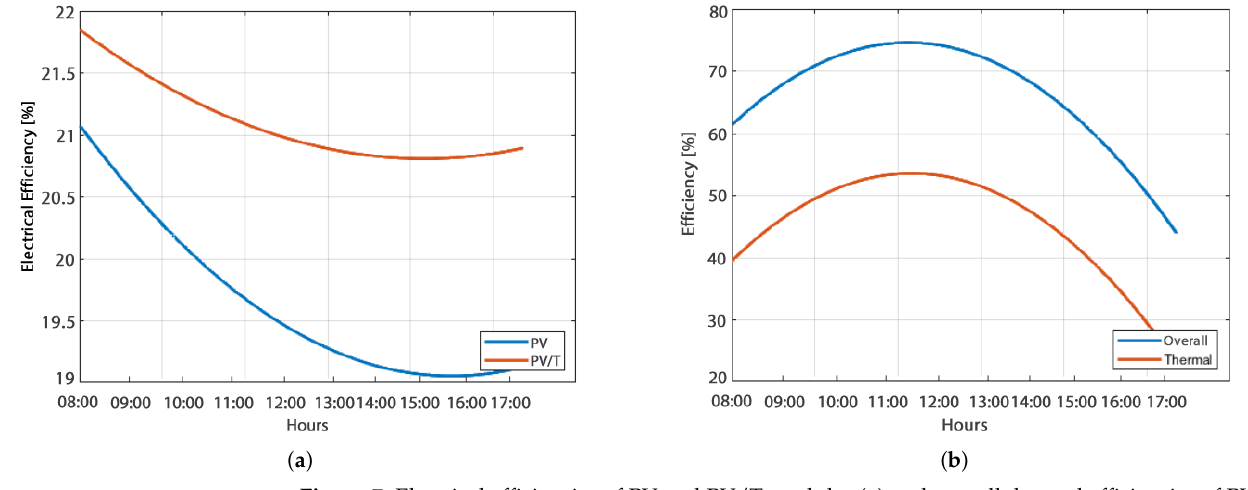
Figure 7. Electrical efficiencies of PV and PV/T modules ( a ) and overall thermal efficiencies of PV/T modules ( b ).